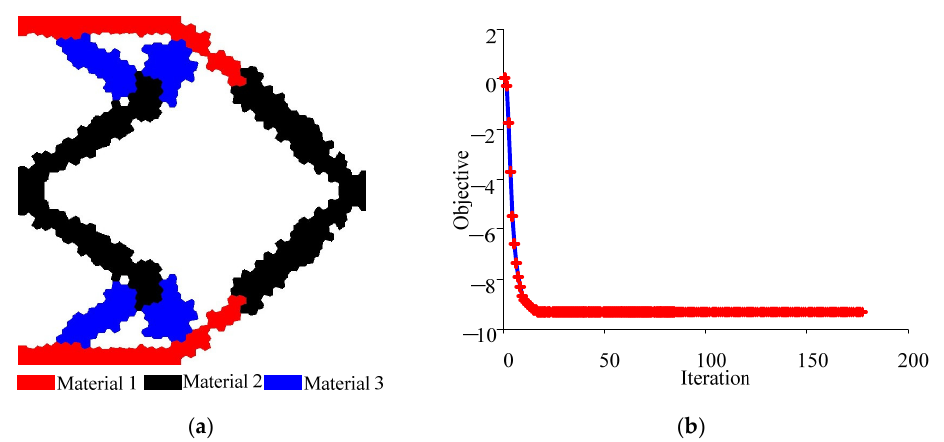
Figure 6. Optimization results of case 2: ( a ) Identifed topologies; ( b ) convergence plot.